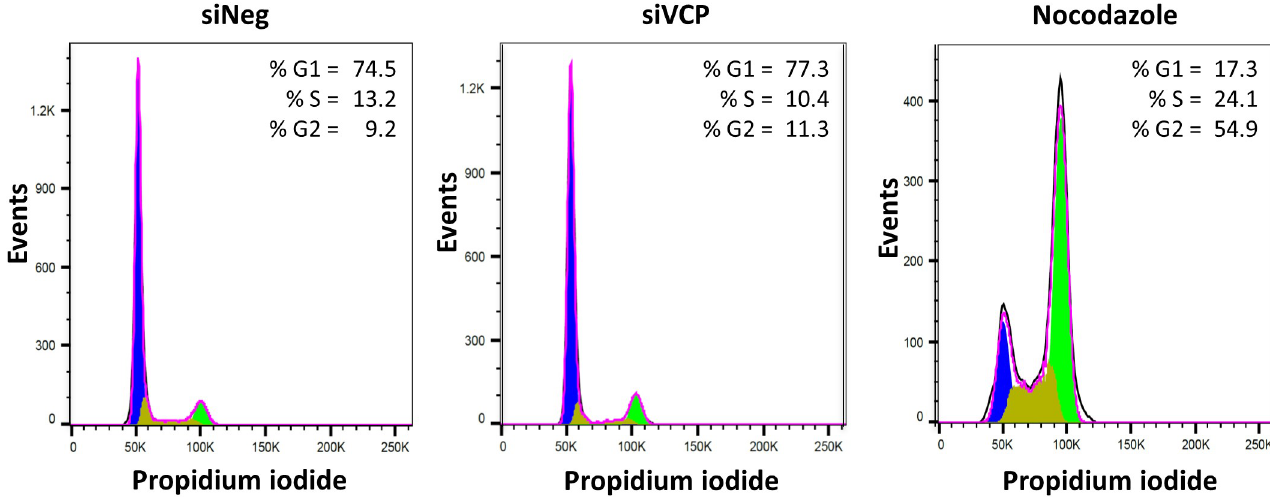
Fig 8. Altered MIE splicing is not due to changes in cell cycle following VCP knockdown. Fibroblast cells were transfected with negative control siRNA or VCP siRNA and cells were fixed and stained with propidiumiodide4 days post transfection. Untransfected cells were treated with 0.5 μ g/ml nocodazole as a positive control of G2/M arrest. DNA content was then measuredby FACS analysisand definedas G1, S or G2 using FlowJo software.